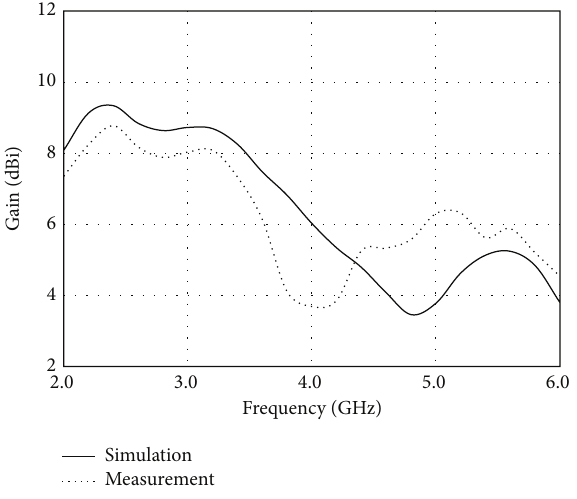
measured half-power beamwidth (HPBW) in the 𝑦𝑧 - and 𝑥𝑧 -planes is 73 and 62 degrees. At 3.5 GHz, the measured HPBWs in the 𝑦𝑧 - and 𝑥𝑧 -planes are identical at 80 degrees, while those at 5.5 GHz are 28 and 40 degrees, respectively.